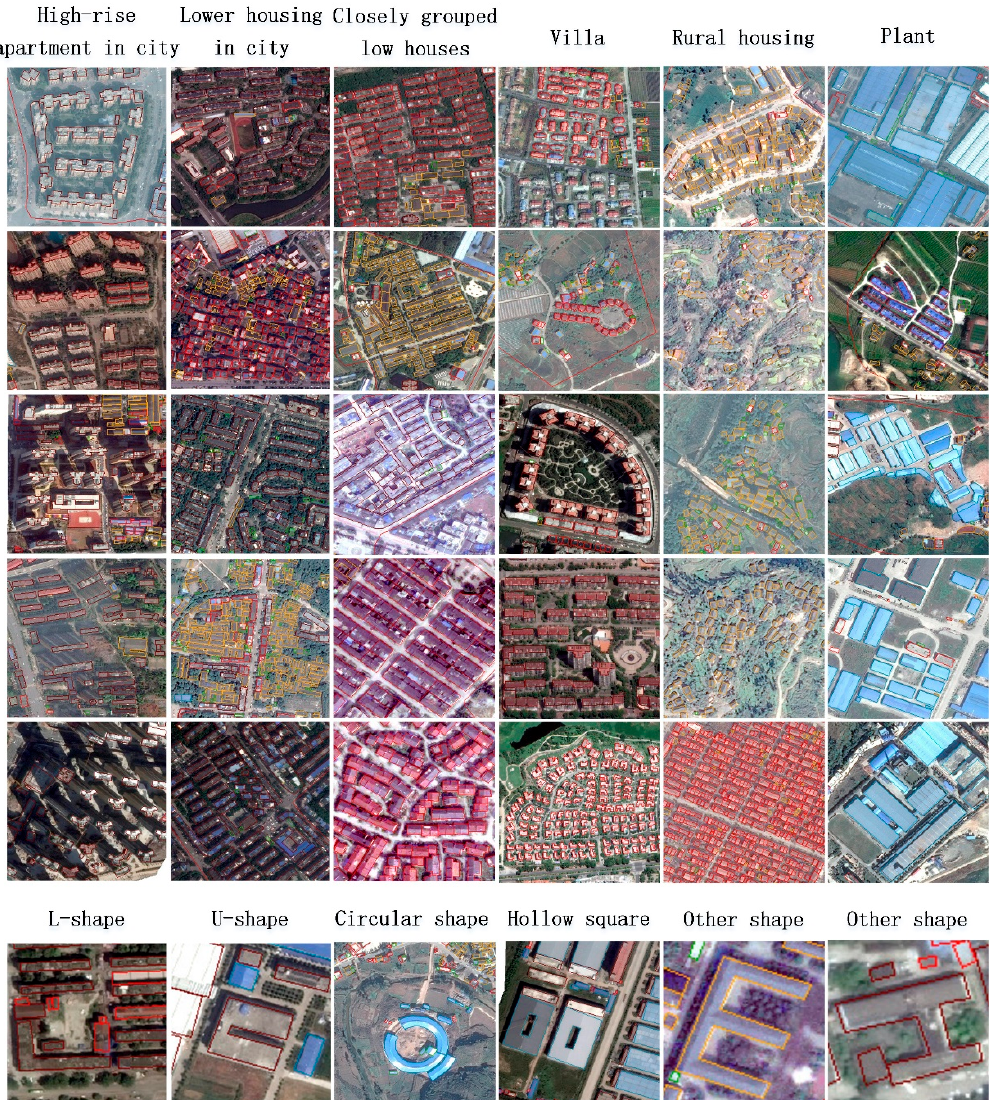
Figure 7. Building samples in our dataset. A variety of buildings with different shapes and architectural structures and functions are selected.